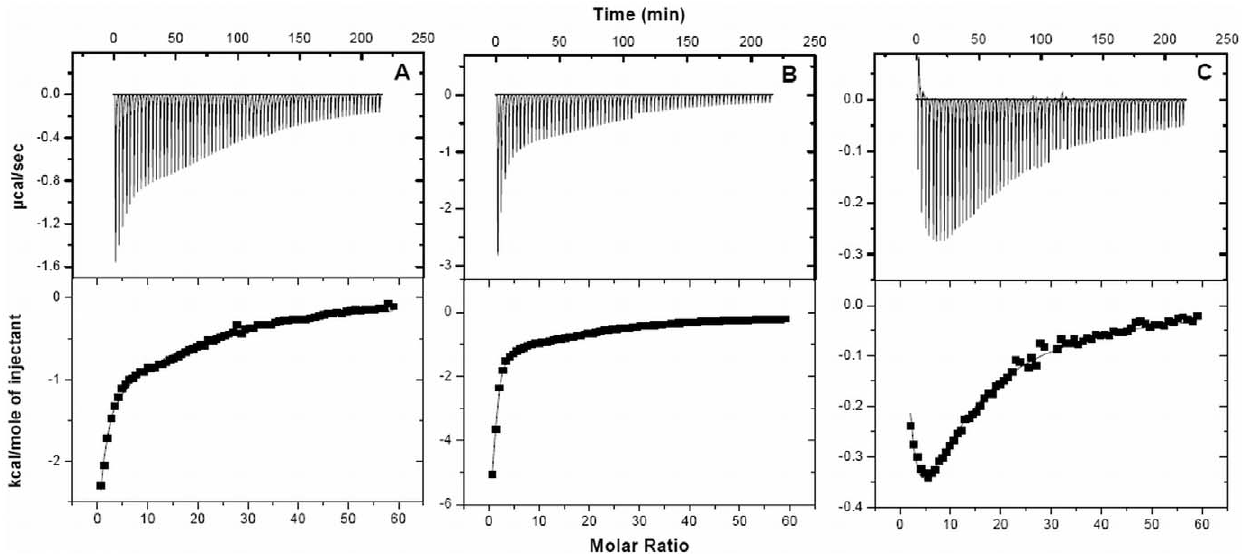
Figure 9. Isothermograms representing the binding of HSA to (A) 1N, (B) 2N and (C) 8H in 20 mM Tris–HCl pH 7.4 at 15 6 C. The upper panels represent the raw data and the bottom panels are the best fits of the raw data fitted to the multiple binding sites model. The concentration of protein was 24.4 m M and the pollutants were 3 mM. Appropriate background corrections were made to account for the heats of dilution and ionization.